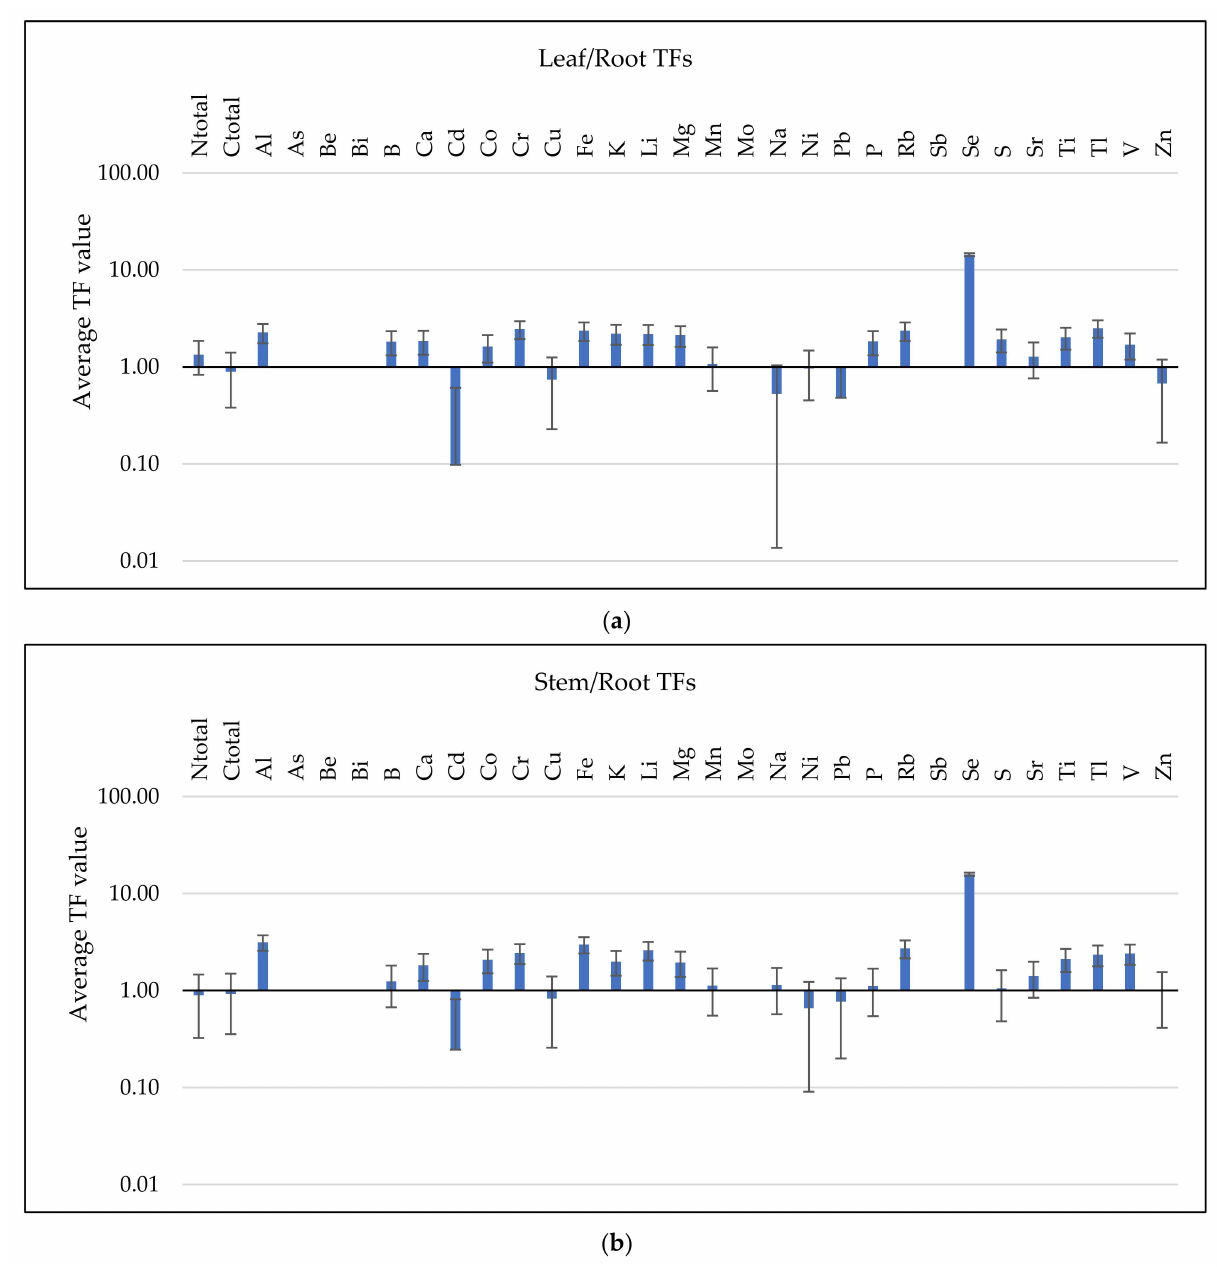
Figure 6. Average TF values obtained from the relationship between the mineral contents of leaves, stems and roots for each element studied for all localities. ( a ) Leaf/Root TFs. ( b ) Stem/Root TFs. Data plotted on log base 10